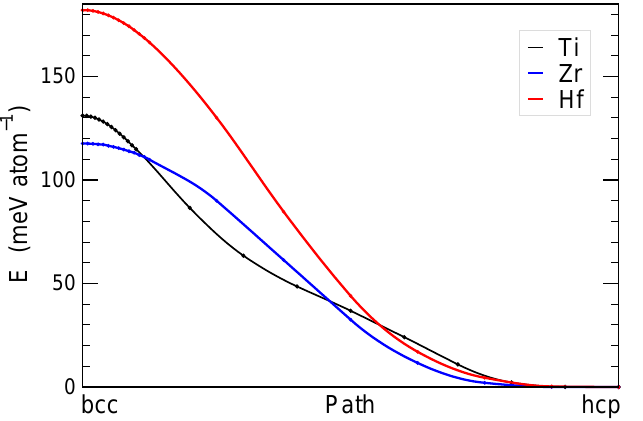
Figure 8. (color online) Minimal-enthalpy path from bcc to hcp has no barrier in Ti, Zr, and Hf